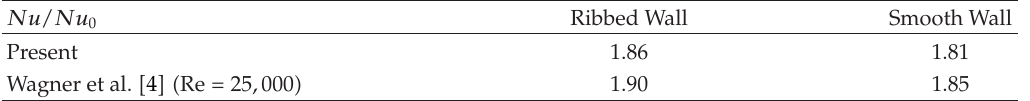
Table 1: Comparison of averaged Nusselt number with Wagner et al. (cid:6) 4 (cid:7)